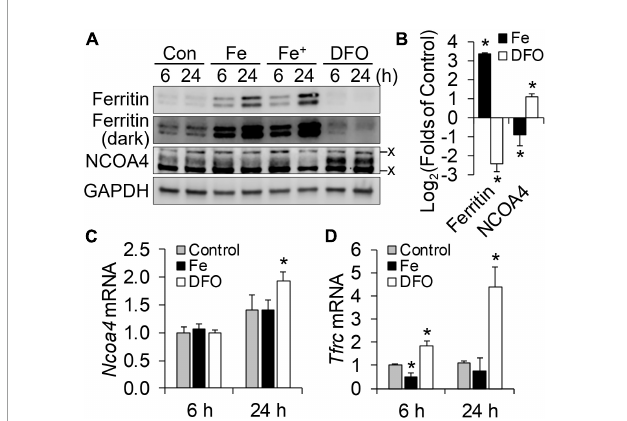
FIGURE1 NCOA4 post-transcriptionally responds to iron availability in HT22 mouse hippocampal neuronal cells. HT22 cells were treated with ferric ammonium citrate (Fe, 200 µ M; Fe + , 400 µ M) and desferrioxamine (DFO, 100 µ M) for cellular iron overload and restriction, respectively. (A) Responses of ferritin and NCOA4 to iron availability, measured by western blot analyses. x, non-specific bands. (B) Quantitation of ferritin and NCOA4 western blots. HT22 cells were treated with Fe or DFO for 24 h ( n = 4 independent experiments). Protein abundance was normalized to GAPDH. (C,D) Effects of cellular iron status on transcript abundance of Ncoa4 (C) and Tfrc (D) , normalized to Tbp levels in HT22 cells ( n = 3 biological replicates). Data are presented as mean ± SD ( n = 3 biological replicates). * P < 0.05, compared with control